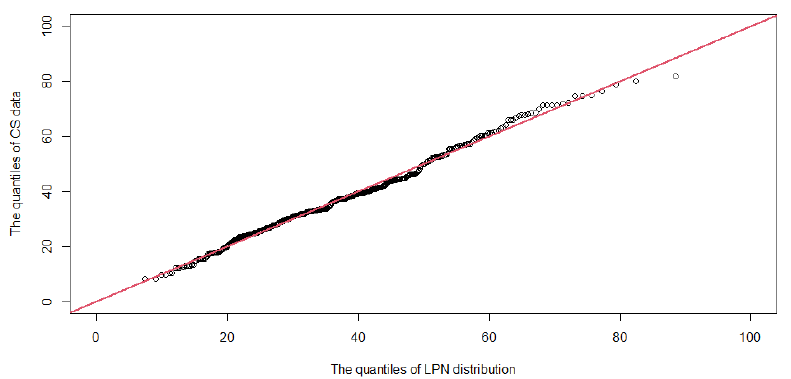
Figure 3. The quantile-to-quantile plot of using LPN ( ˜ ξ , ˜ σ , ˜ γ ) as the probability model of the CS data